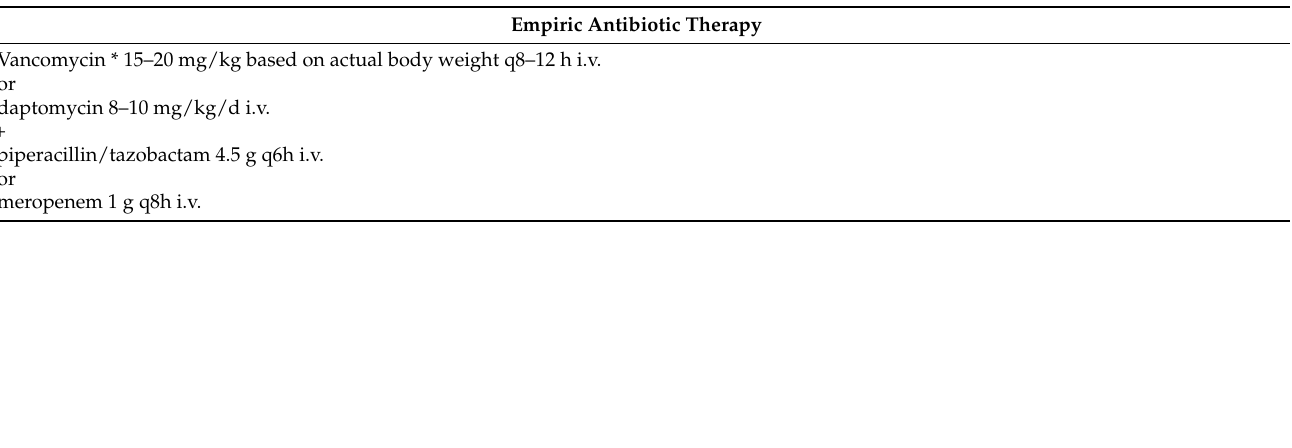
Table 3. Antibiotic therapy options for surgical site infection in cardiac